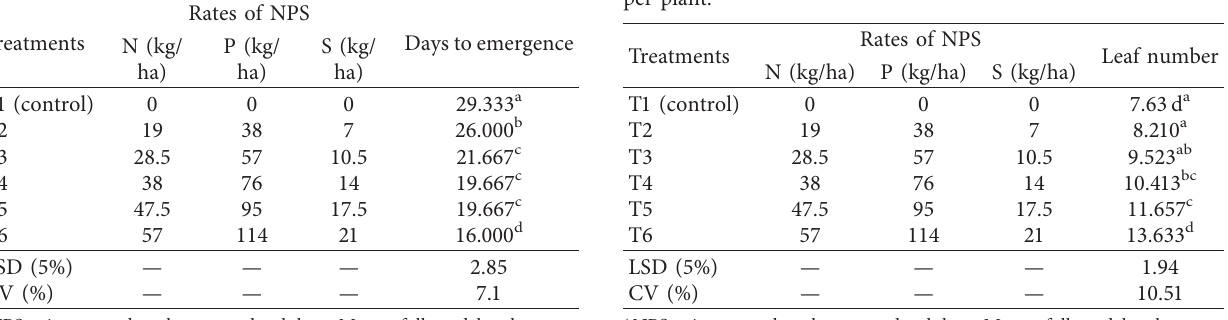
Table 3: Effect of different rates of NPS fertilizer on leaf number per plant.